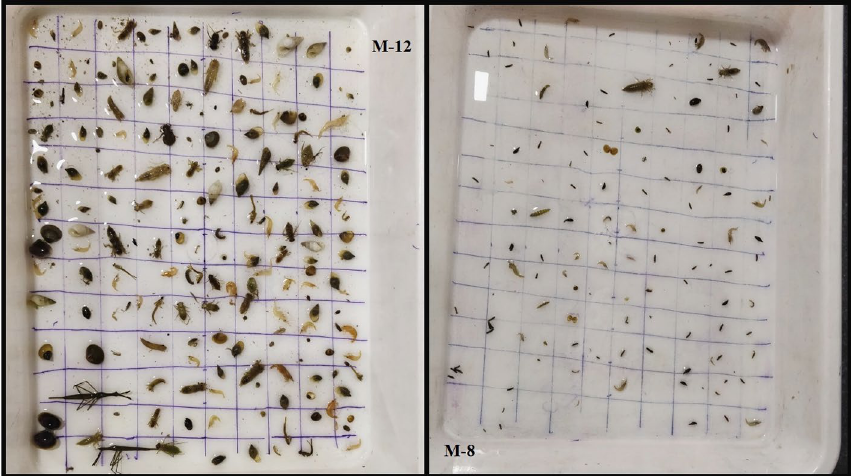
Fig. 2 Biological assessment of benthic macroinvertebrates in